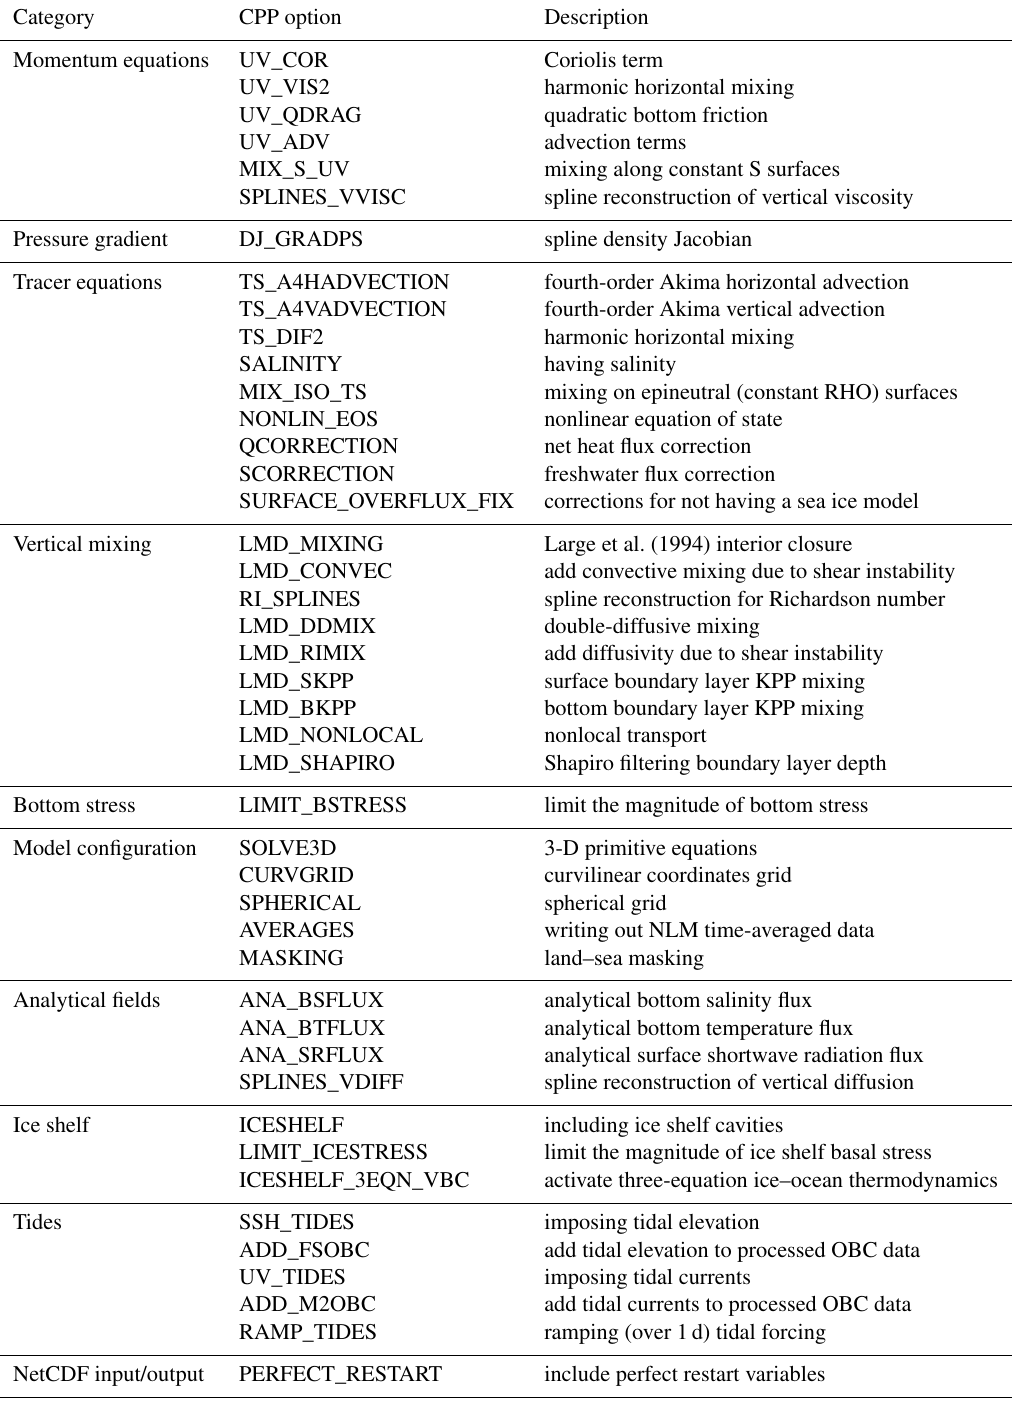
Table C1. Activated ROMS options in